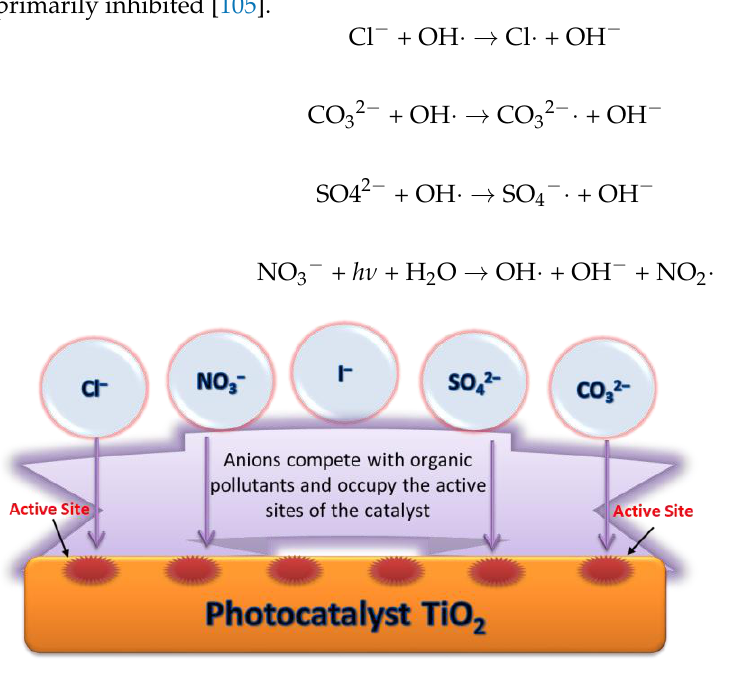
Figure 5. The competitive adsorption of anions and organic